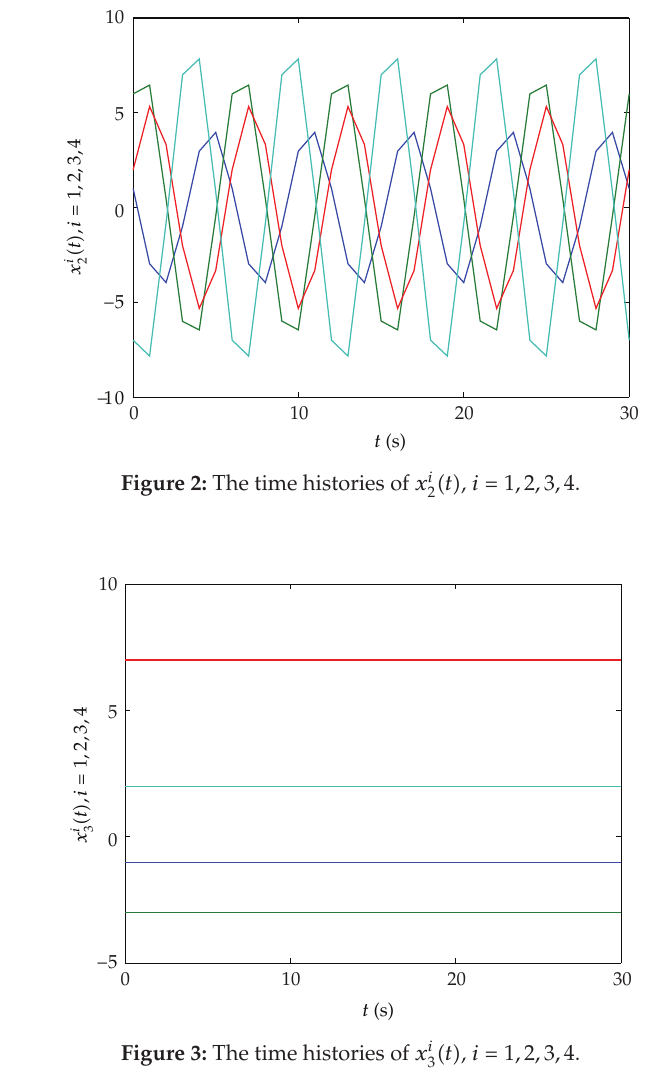
Figure 3: The time histories of x i